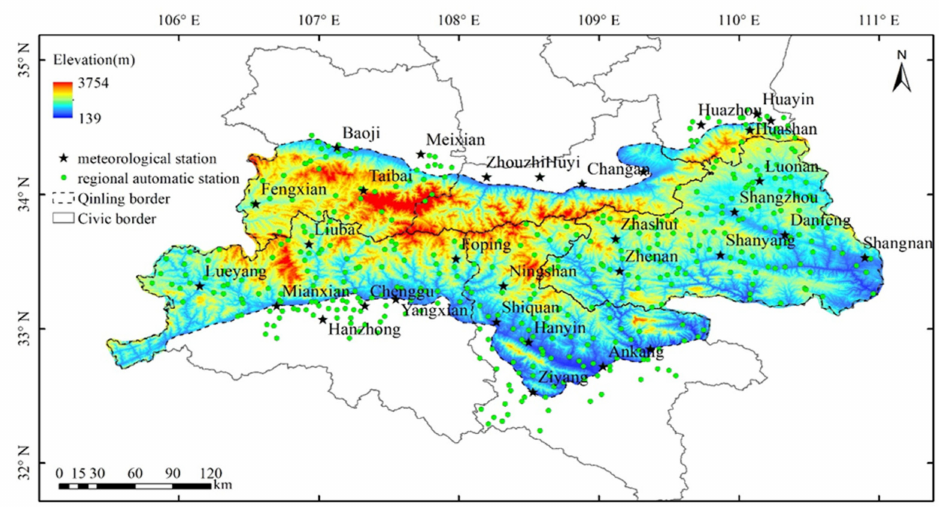
Figure 1. Spatial distribution of meteorological stations in the Qinling